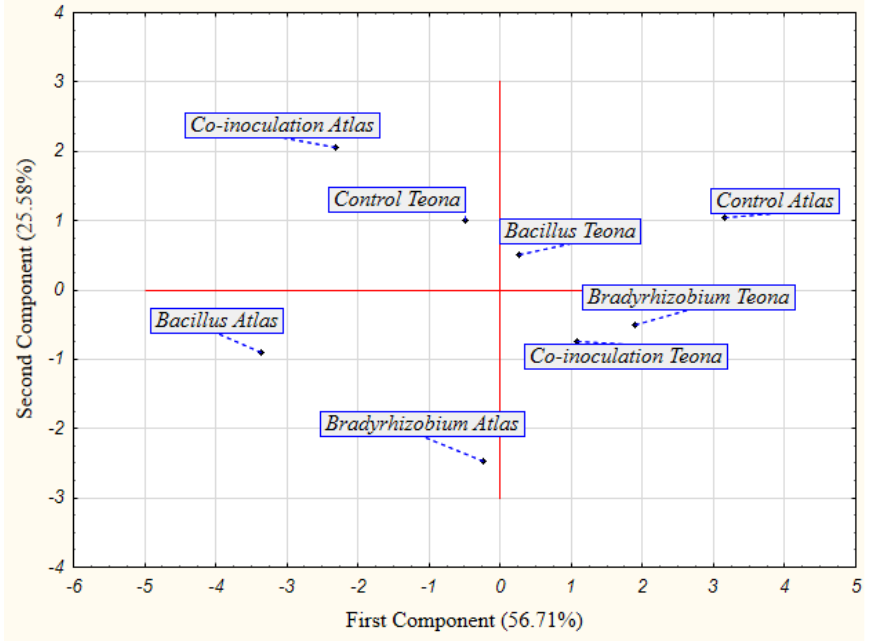
Figure 3. Principal component analysis (PCA) for the effect of seed bio-priming treatments on the examined parameters of soybean cultivars in accelerated aging test.